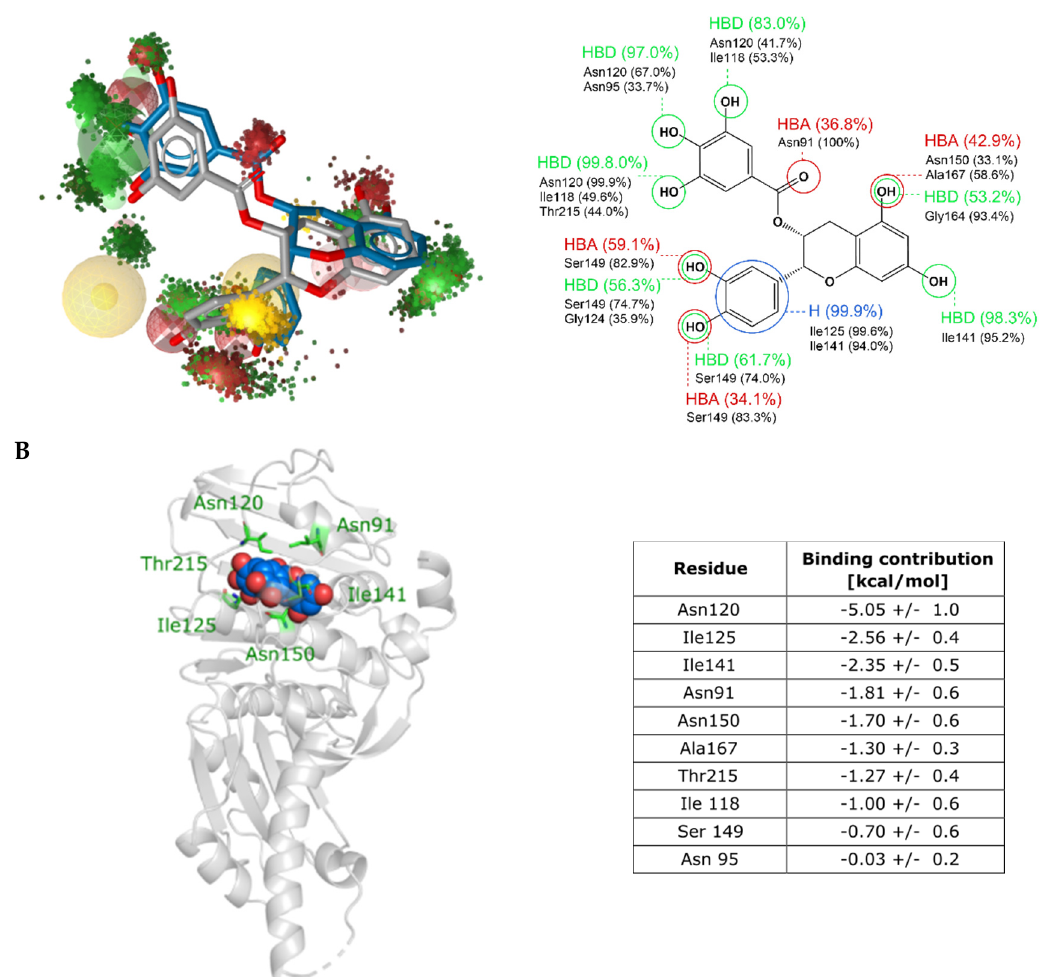
Figure 8. ( A ) Dynophore model for the selected compound 6. ( Left ) Overlay of our 3D dynophore model with the point cloud representation of superfeatures with the screening pharmacophore and overlay of the conformation of compound 6 from pharmacophore screening (grey) with the conformation of compound 6 from the later stages of the MD simulation (blue). ( Right ) Detailed insights into the interaction patterns with amino acid residues and statistical information). ( B ) Per-residue energy decomposition of binding free energy. Compound 6 is depicted in blue and the residues that contribute the most to its binding are in green.